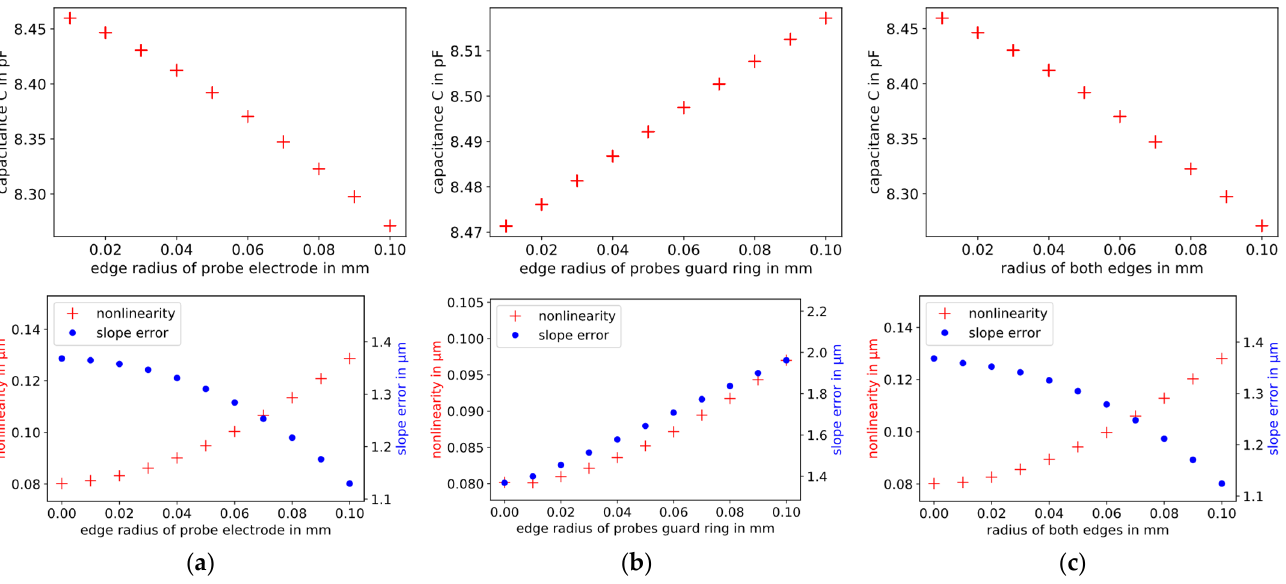
displacement measurements. With increasing gap width, the slope error increases linearly and the nonlinearity exponentially.